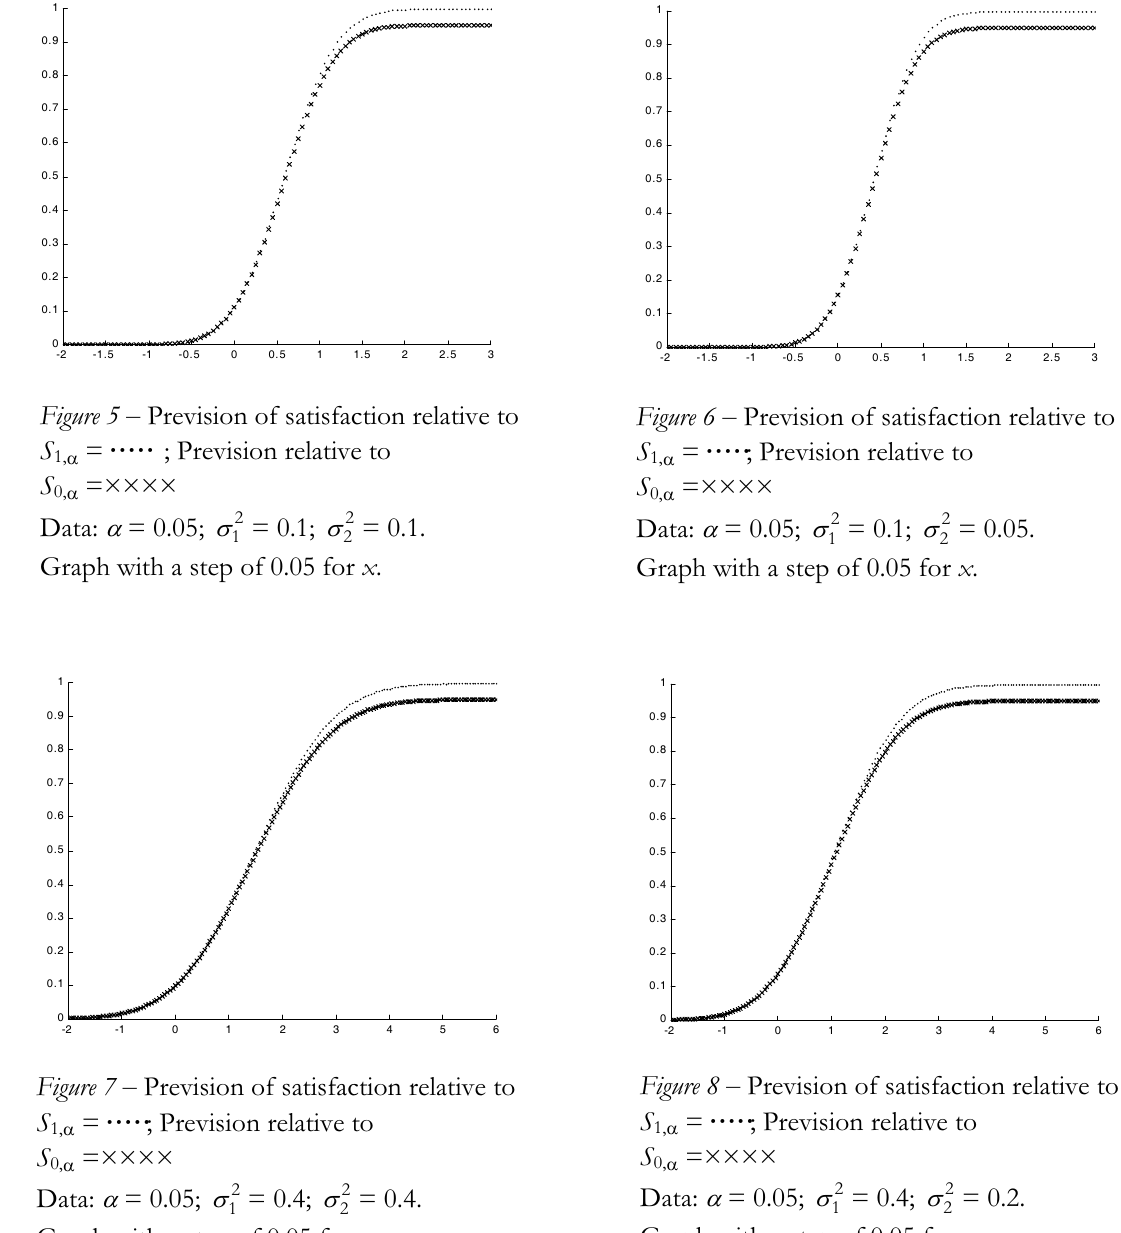
Graph with a step of 0.05 for x